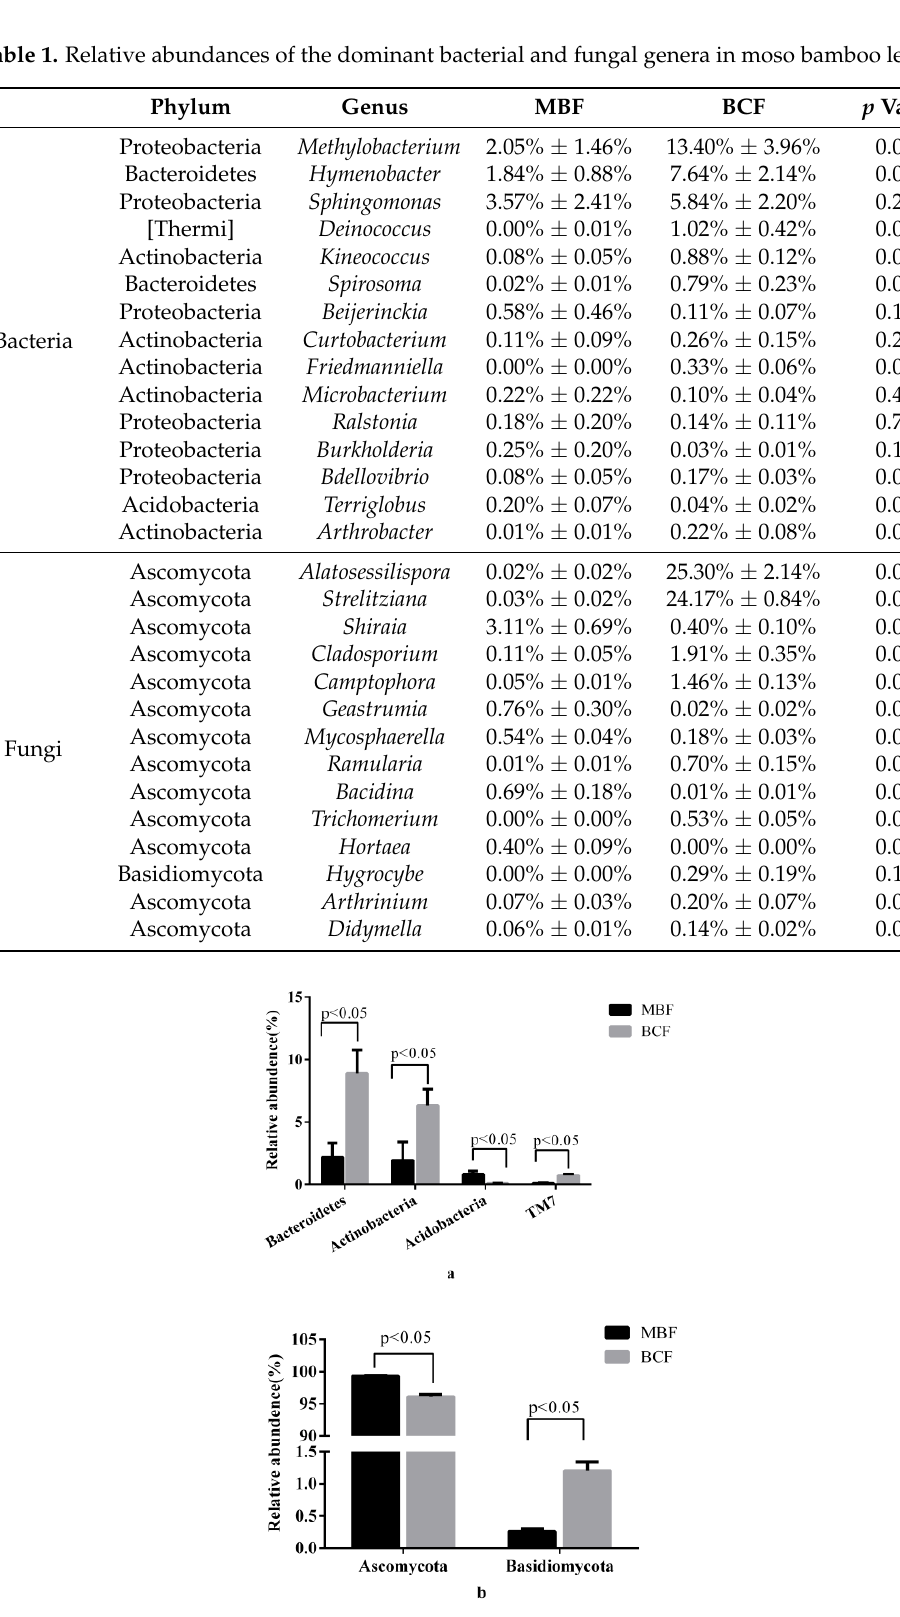
Figure 2. Differences in the dominant phyla of the moso bamboo leaf-associated microbiome in the BCF and MBF samples. ( a ) Bacteria; ( b ) fungi.